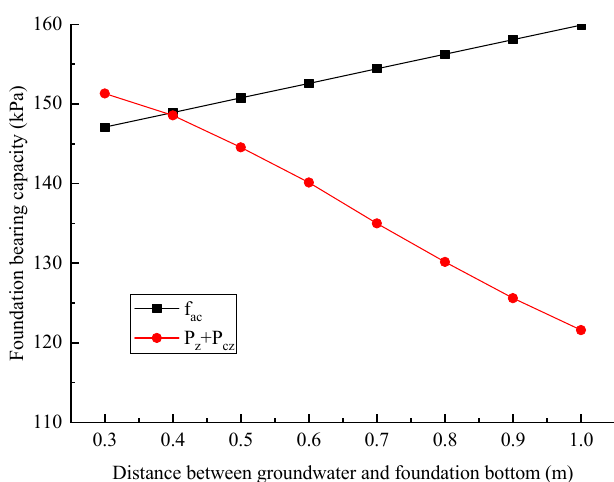
Figure 7. Schematic diagram of the influence of the rising groundwater level on the safe depth.